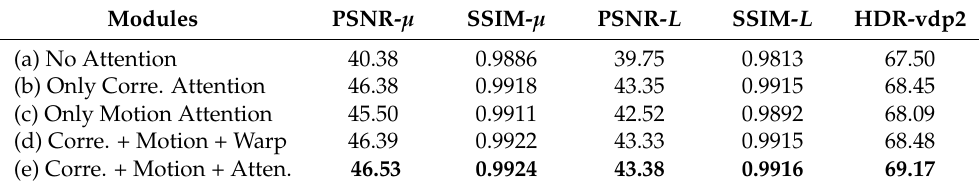
Table 3. Impacts of different modules for the fusion framework, where Corre. and Atten. are abbreviations of Correlation and Attention, respectively. The last structure (e) is adopted in our